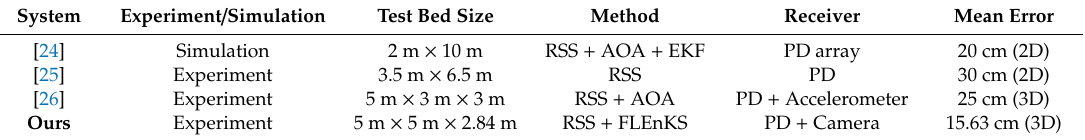
Table 6. Comparison of the Proposed Visible Light Positioning (VLP) System with Other Existing Systems.